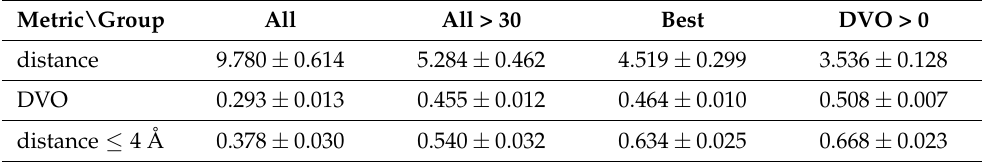
Table 3. The achieved values of the distances to binding site center and discrete volumetric overlap (DVO) for four groups of binding sites. The table cells display values in the form average ± standard deviation, obtained from 10 models that were evaluated on independent test sets.